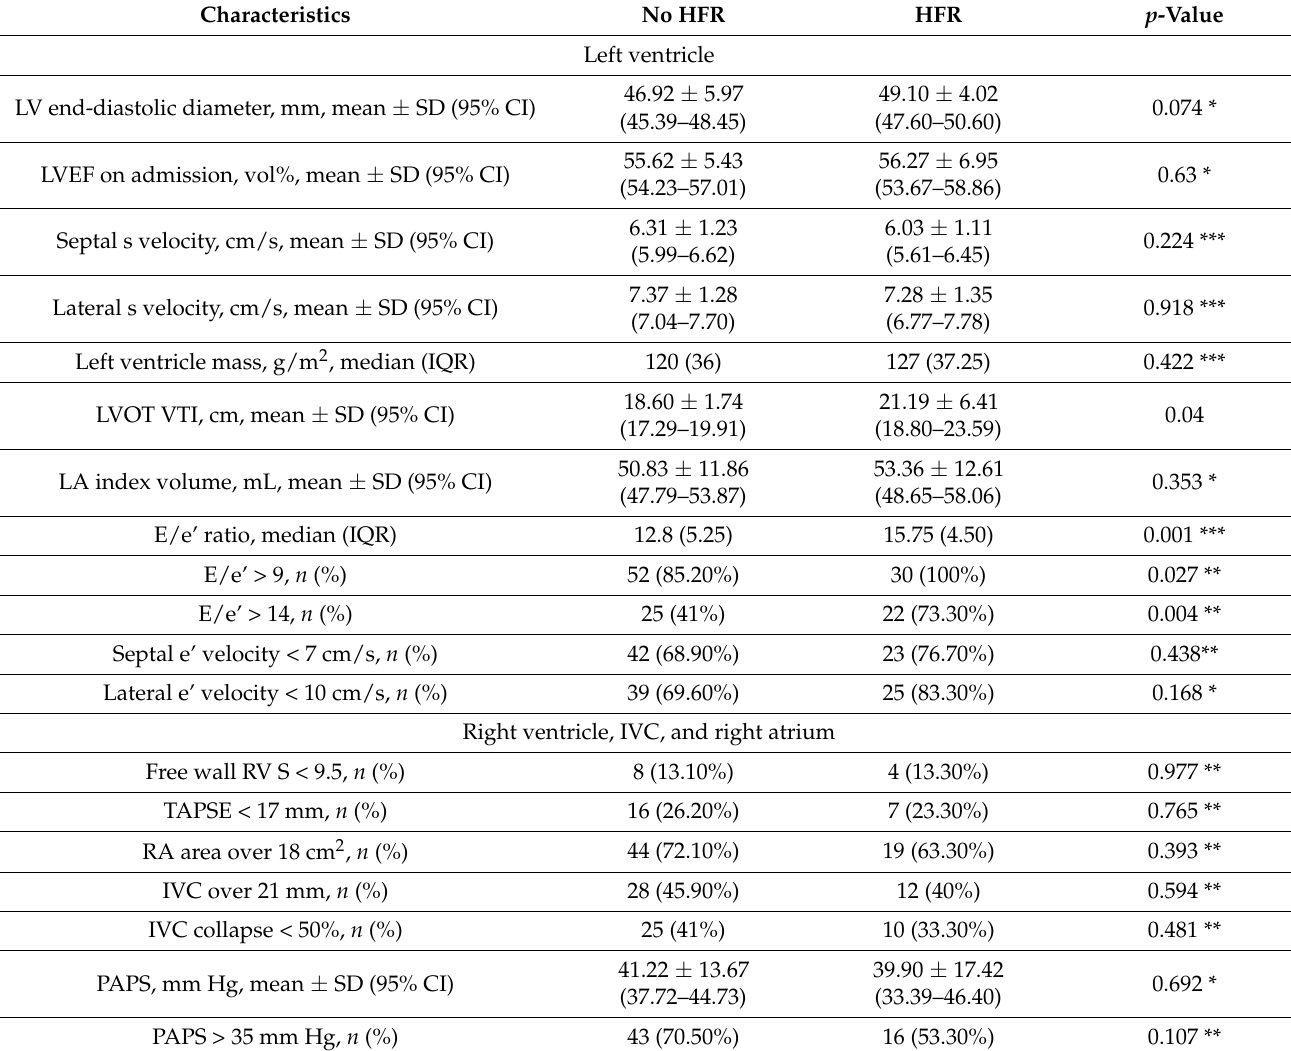
Table 2. Transthoracic echocardiography features in patients with HFpEF, with and without HFR.